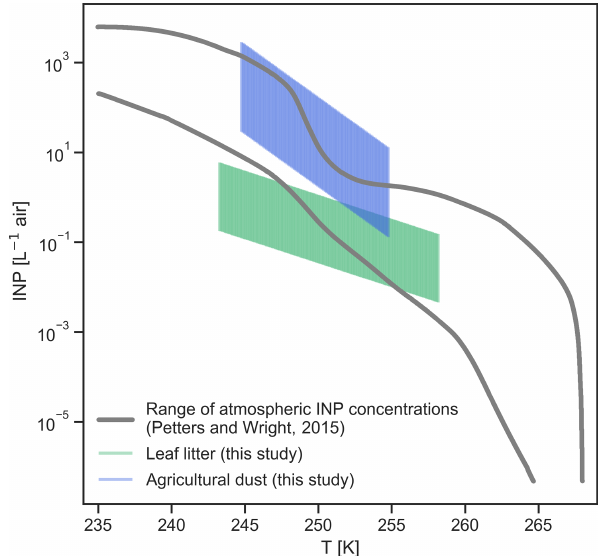
Figure 3. Comparison between atmospheric INP concentrations (Petters and Wright, 2015) and estimates for INPs from leaf litter and agricultural dust based on AIDA cloud chamber